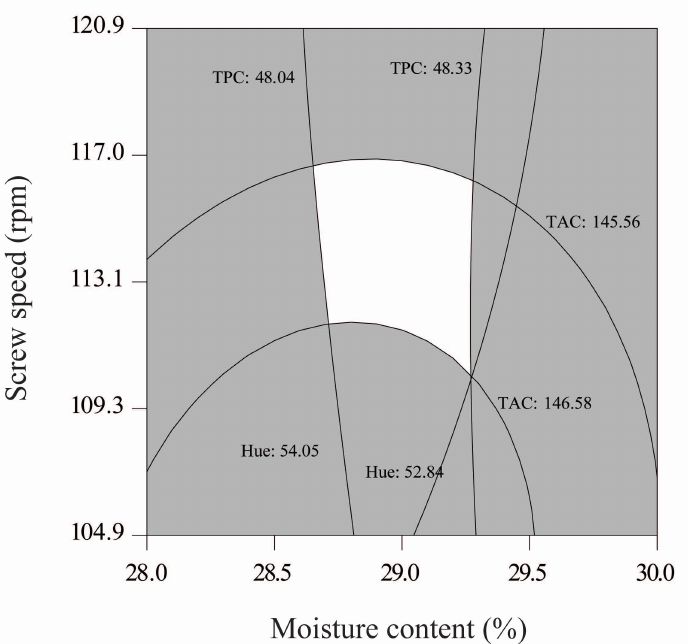
Figure 5. Optimized region obtained of contour plots of the physicochemical characteristics of extruded pellets: TAC = total anthocyanin content (mg cyanidin 3-glucoside /kg), TPC = total phenolic content (mg GAE/100 g) and